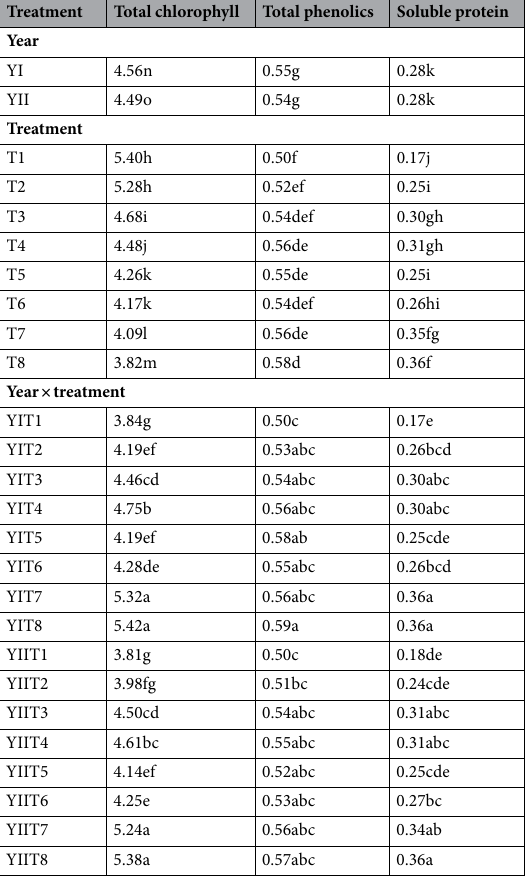
Table 2. Effect of seed priming on total chlorophyll, phenolics, and soluble protein contents (mg g -1 fresh weight) in direct-seeded rice seedlings in a field experiment during 2019 (YI) and 2020 (YII). Means followed by different letters (Tukey ranking) differ significantly at 5% level of significance. Treatments details are given in Table